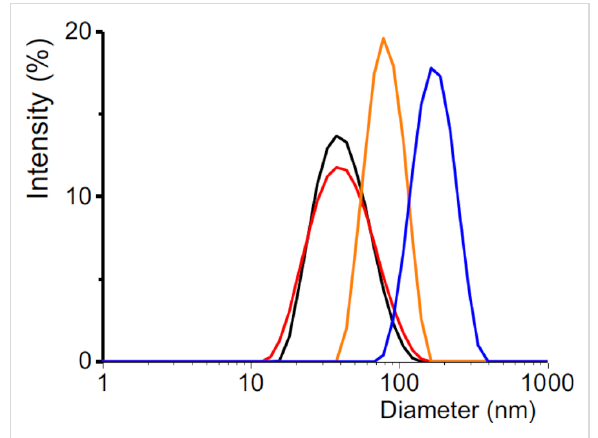
Figure 2: Hydrodynamic diameter distributions of IONPs grafted with dendrons: C 2 H 5 OEG 8 Den (38 ± 1 nm, black), C 2 F 5 OEG 8 Den (37 ± 1 nm, red), C 4 H 9 OEG 8 Den (95 ± 12 nm, orange), C 4 F 9 OEG 8 Den (197 ± 15 nm, blue) in aqueous dispersions (Fe conc. 0.05 mg mL − 1